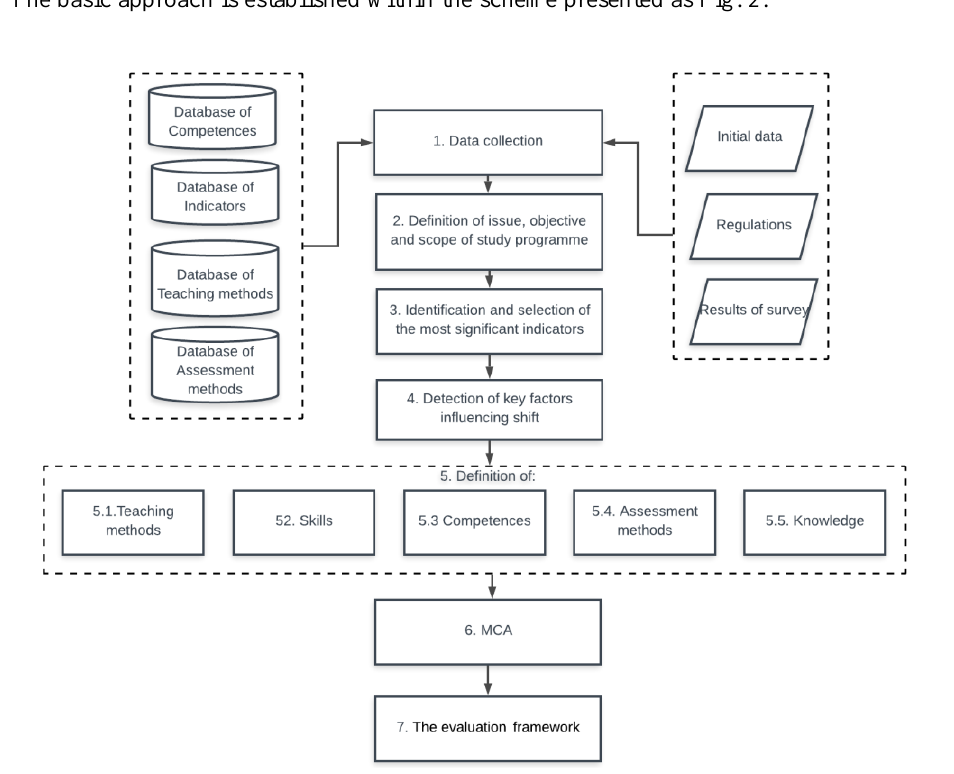
Fig. 2. Overall methodological